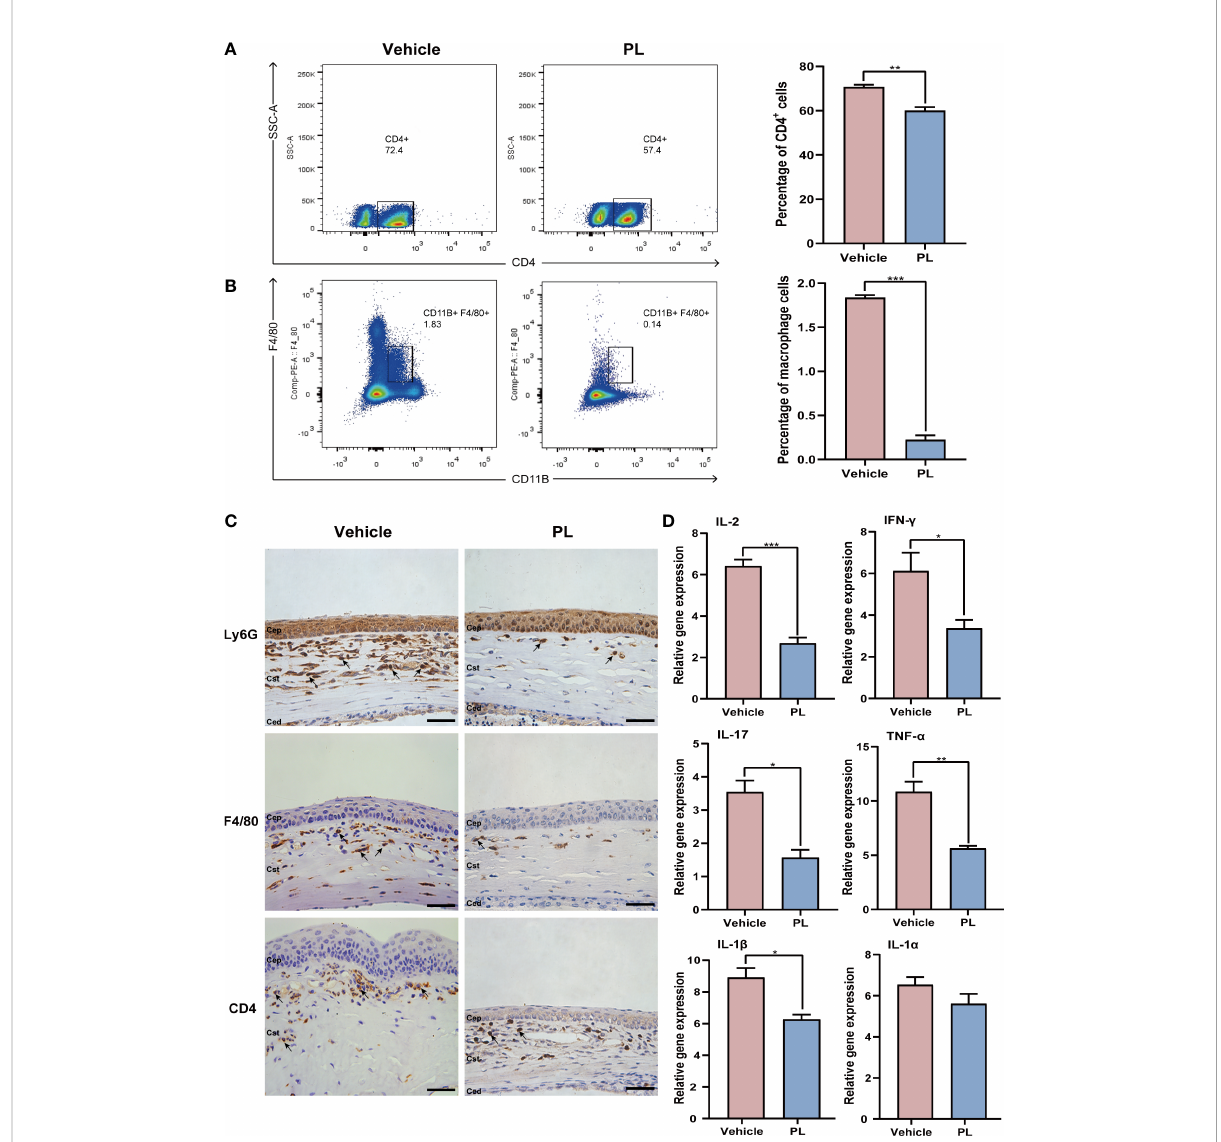
(B) Representative fl ow cytometry plots and statistical analysis of CD11B + F4/80 + macrophage frequencies from two groups on postoperative day 14 (n = 10/group). (C) Representative immunohistochemistry of Ly6G + neutrophils, CD4 + T cells and CD11B + F4/80 + macrophages in the cornea from two groups on postoperative day 14 (n = 4/group). scale bar 100 µm. (D) The mRNA levels of in fl ammatory cytokines were detected by qRT-PCR (n = 6/group). * P < 0.05, ** P < 0.01, ***P <